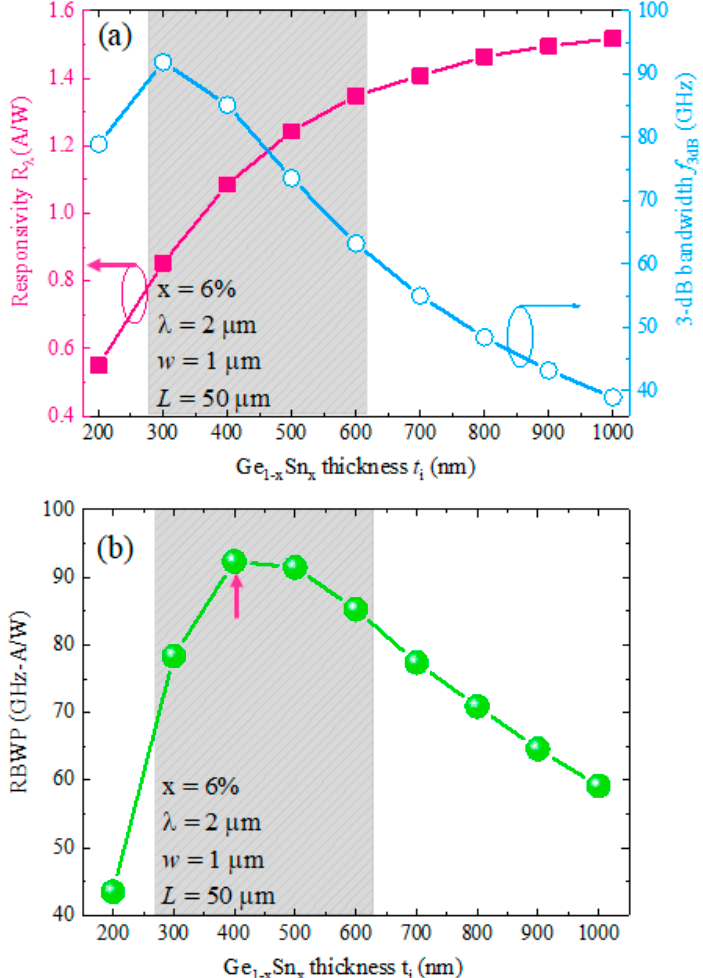
Figure 7. ( a ) Calculated responsivity and 3-dB bandwidth as a function of Ge 1 − x Sn x active layer thickness at λ = 2 µm. ( b ) Calculated responsivity–bandwidth product (RBWP) against Ge 1 − x Sn x thickness at λ = 2 µm.